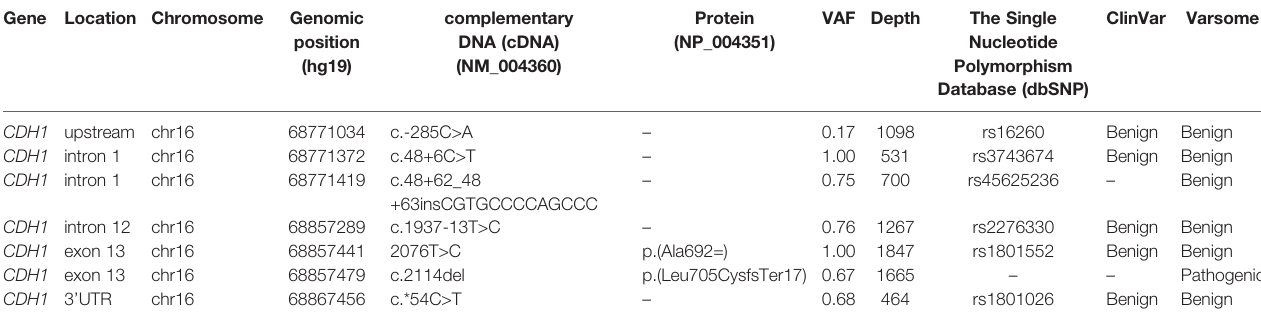
TABLE 2 | CDH1 somatic variants of the patient